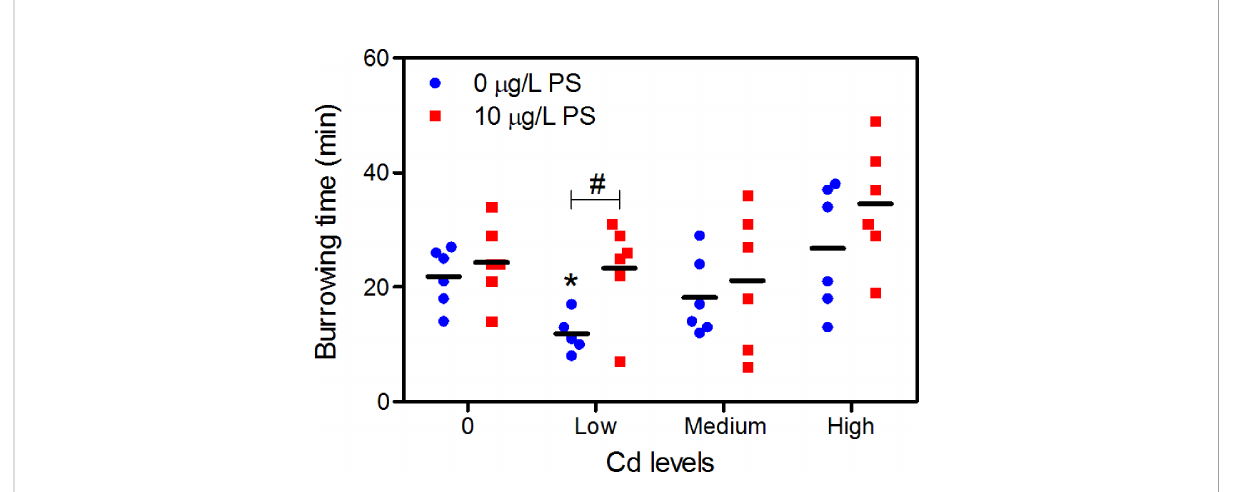
FIGURE 3 Burrowing time of P. aibuhitensis after 7 days of exposure to Cd alone and Cd combined with 10 m g/L of PS. Results are presented as scatter plot ( n = 5 – 6) and mean (black bar). Signi fi cant difference against controls is shown as *( p < 0.05), while the difference between Cd and Cd + PS exposure is shown as # ( p <